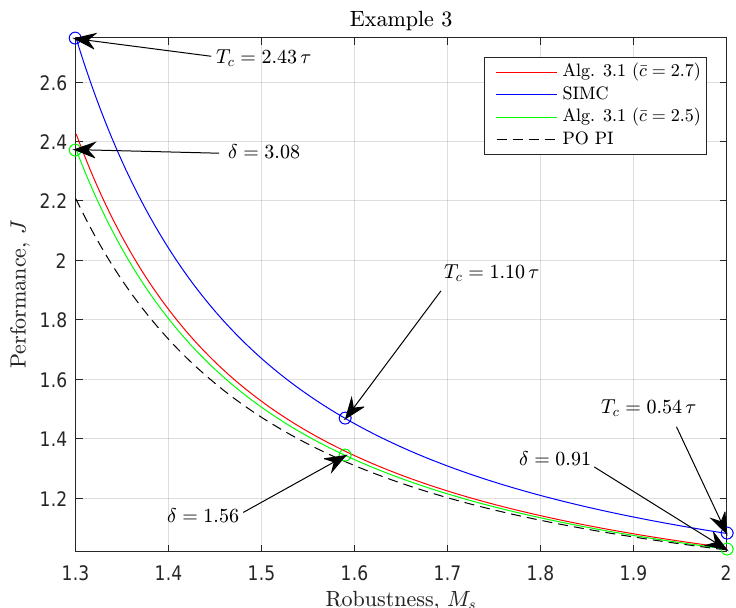
Figure 6. Example 3. Consider PI control of the FOPTD process model, H p ( s ) = K e − τ s τ = 4 and T = 60. The figure shows the trade-off curves with the Pareto performance objective J (Equation (41)) and robustness M s (Equation (10)). It illustrates the MP parameters ¯ c = 2.5 and ¯ c = 2.7 for Algorithm 1 (proposed in Section 4). SIMC with set-point time constant T c is added for comparison.